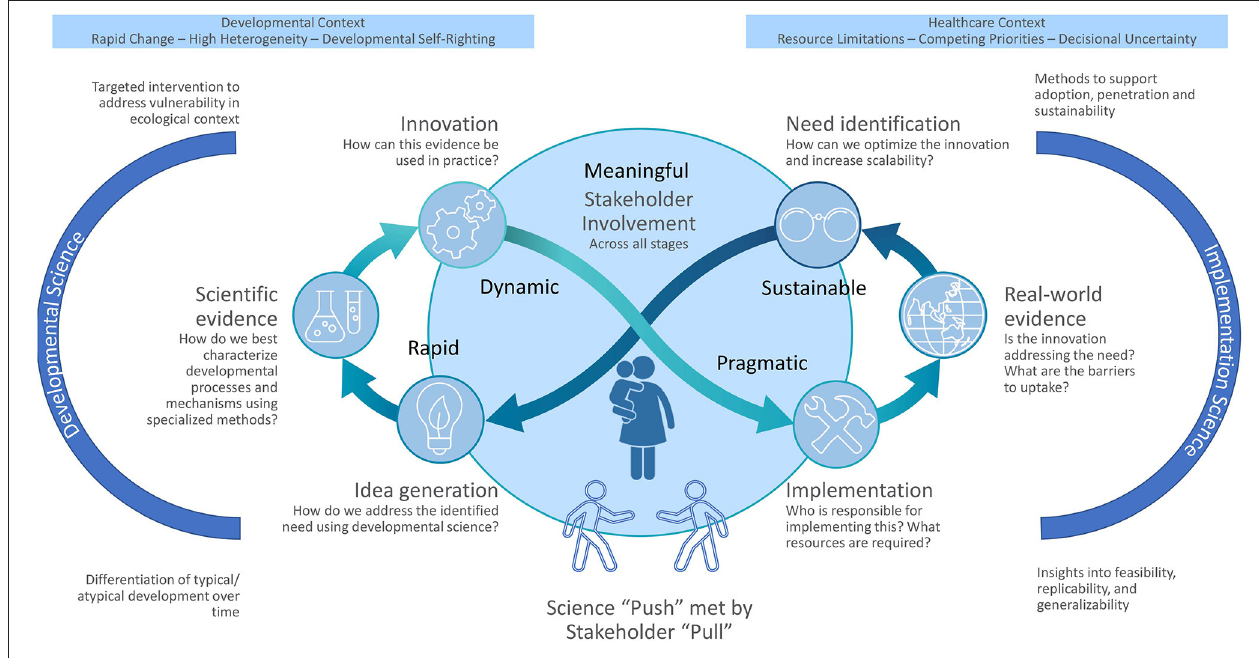
FIGURE 1 | Integrated developmental-implementation sciences framework.